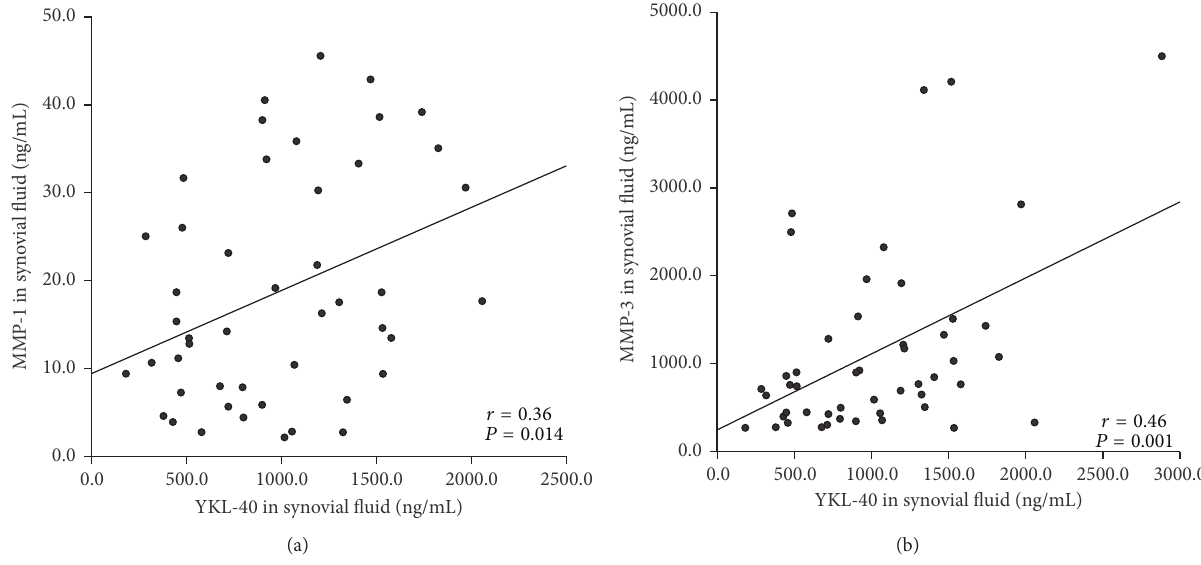
Figure 2: YKL-40 correlated with MMPs in synovial fluid. YKL-40 concentrations correlated positively with those of matrix metallopro- teinases (a) MMP-1 and (b) MMP-3 in SF from OA patients ( 𝑟 = 0.36 , 𝑃 = 0.014 and 𝑟 = 0.46 , 𝑃 = 0.001 ,